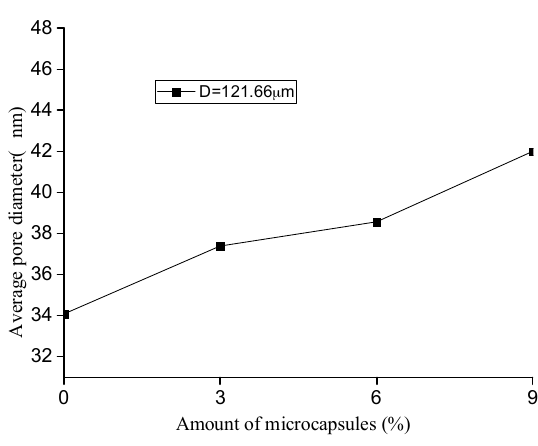
Figure 13. Variation in the average pore diameter with amount of microcapsules.